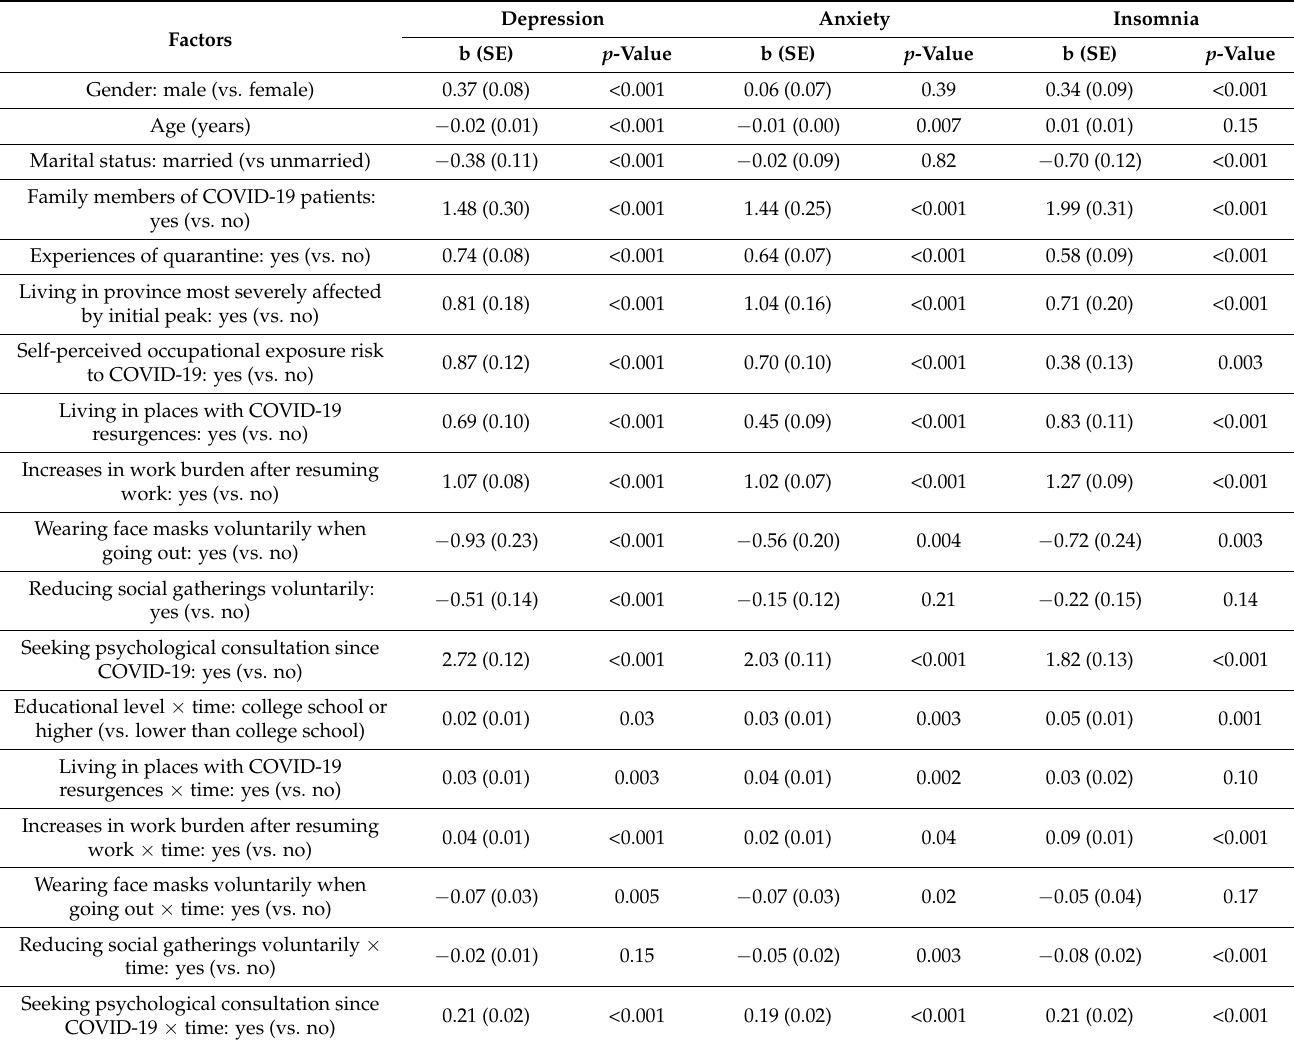
Table 5. Associated factors of scores of depression, anxiety and insomnia symptoms during the course of COVID-19 in the multivariable generalized linear mixed models a